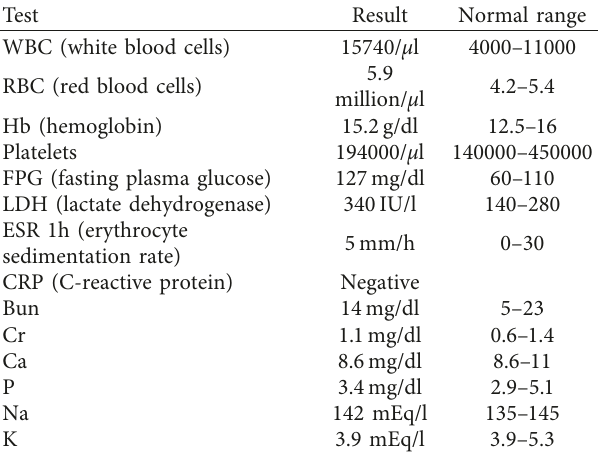
Table 1: Initial laboratory workup